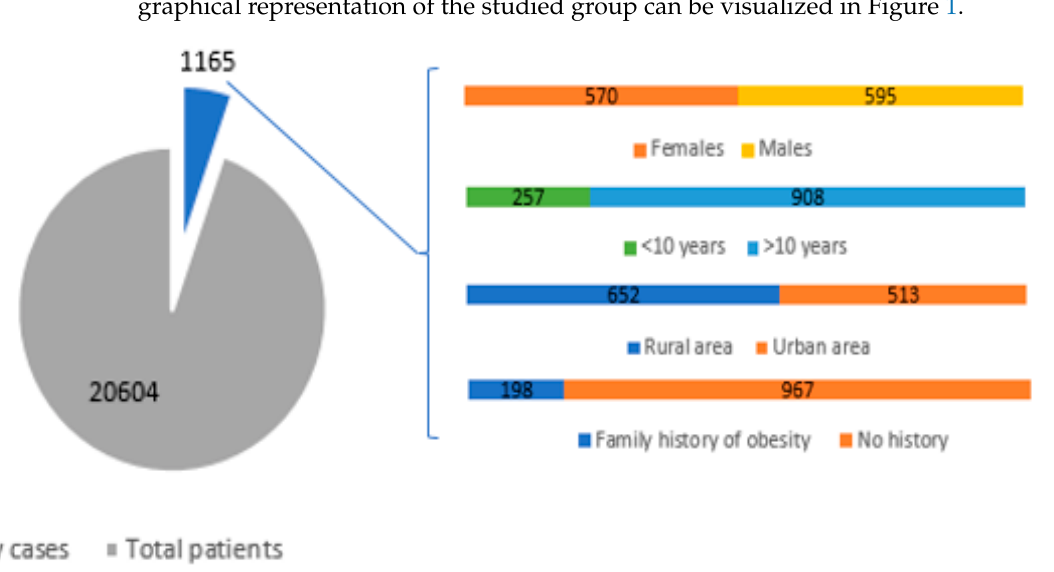
Figure 1. Graphical representation of the studied group. Table 1. Results of our study summarized.